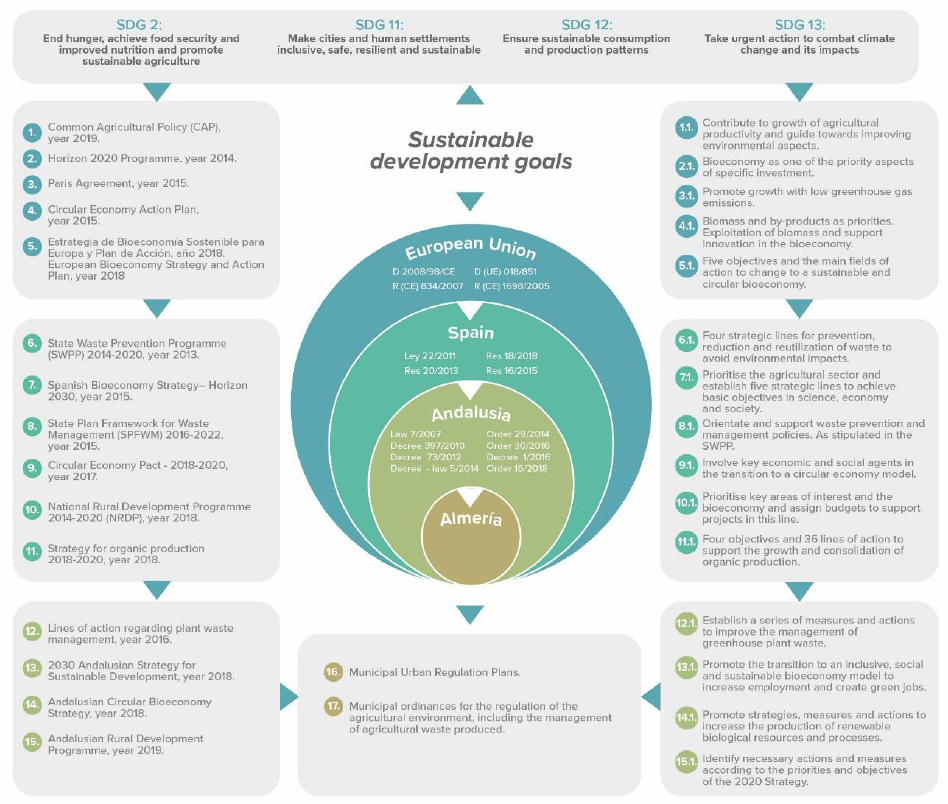
Figure 5. Policies framework, regulatory tools and strategies that promote integrated management of agricultural waste biomass. D: Directive; R: Regulation; Res: Resolution. Source: Authors’ own elaboration.